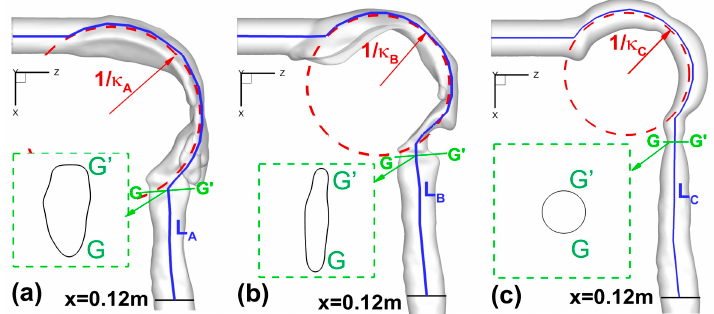
Figure 2. Morphological parameters of the upper airways: ( a ) Geometry A; ( b ) Geometry B; ( c ) Geometry C.